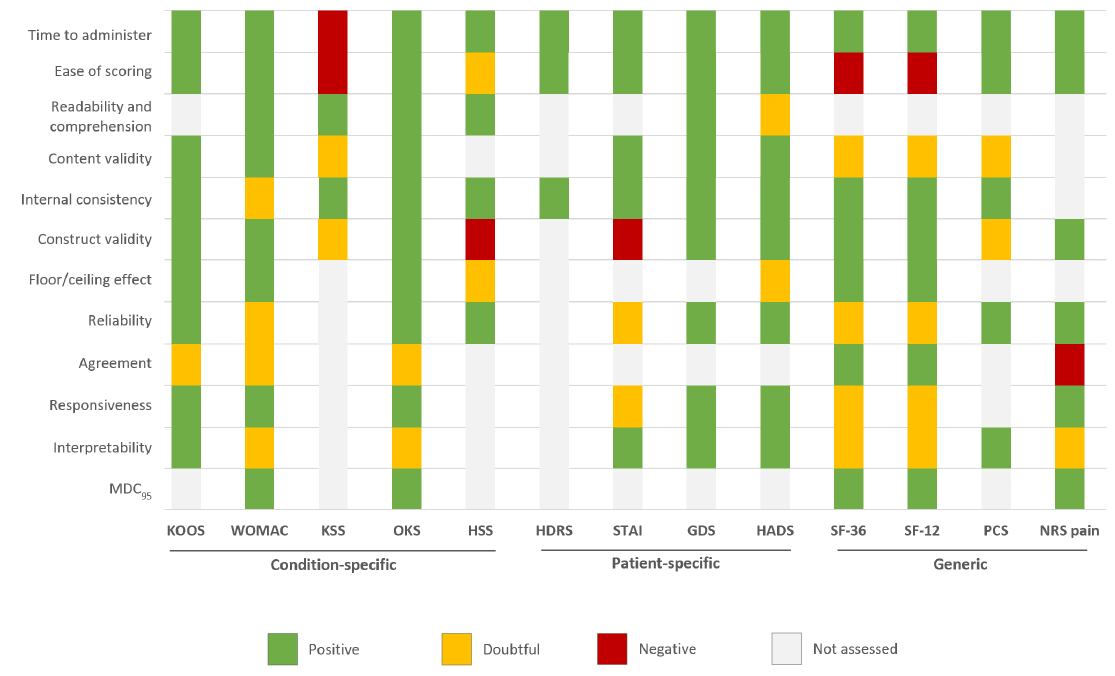
Figure 2. Summary of the quality assessment of patient-reported outcome measures included. MDC 95 = minimal detectable change at the 95% confidence level; see Table 2 for additional abbreviations.